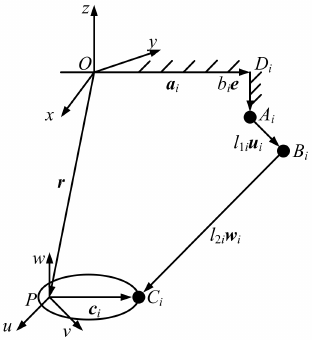
Figure 2. Schematic diagram of a kinematic